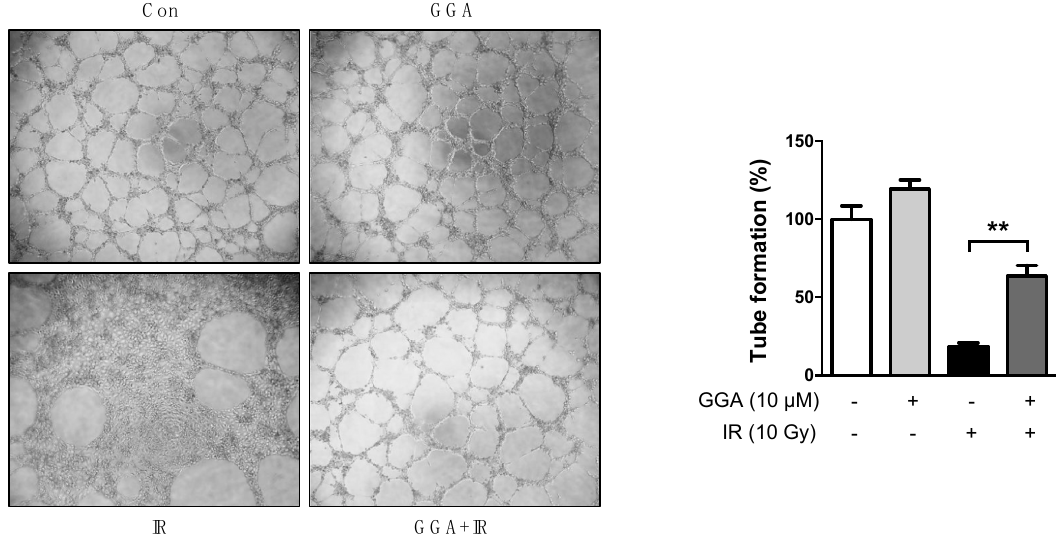
Figure 5. Protective effects of GGA on tube formation activity following IR. Images showing irradiated HUVEC tube formation with 10 µ M GGA treatment; The tubules were counted and compared in each group (40 × ). All data represent the mean ± SEM of three independent experiments; ** p < 0.01.